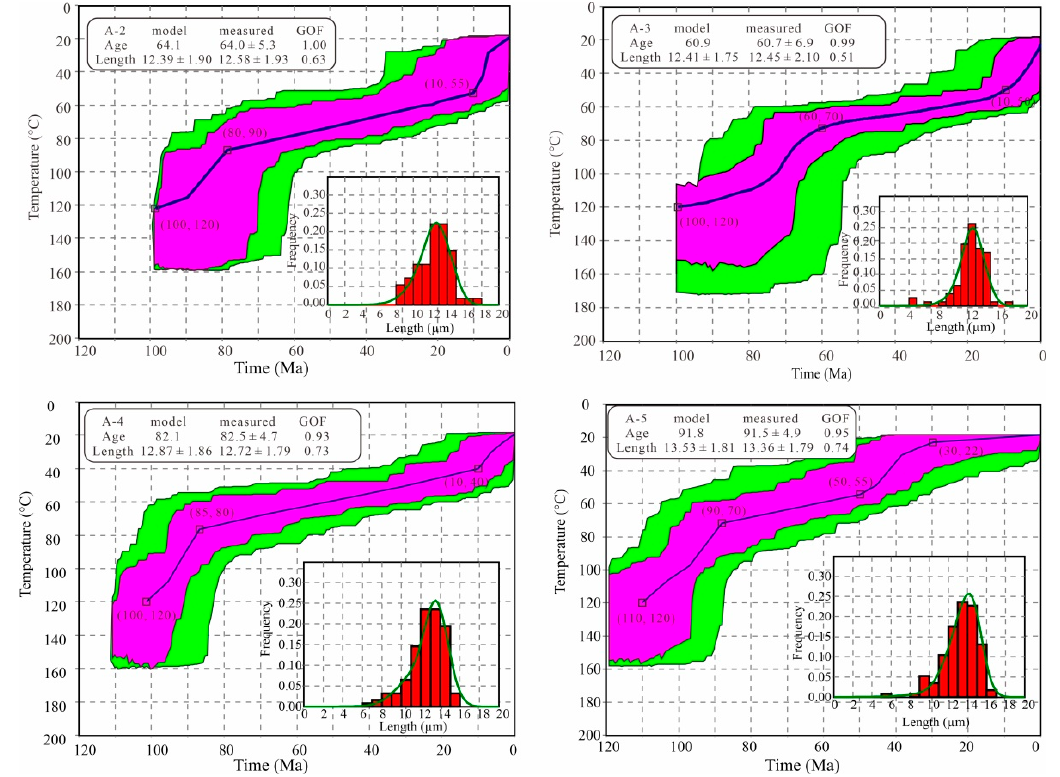
Figure 6. HeFTy thermal path evolution simulation results and histograms of AFT lengths of samples from Altay Mountain. The purple areas represent highly credible intervals of simulation. The green areas represent acceptable intervals. The black lines represent the best fit paths.